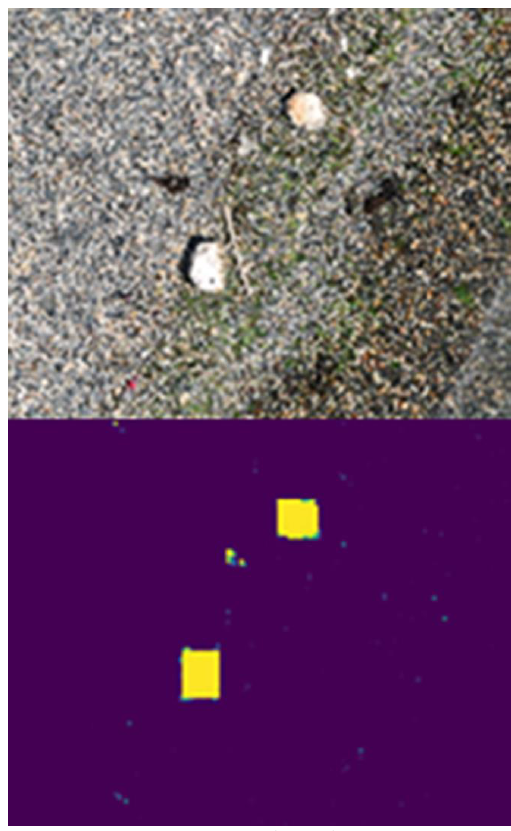
Figure 6. Detection result of styrofoam contaminated surfaces(top : input image, bottom : detection